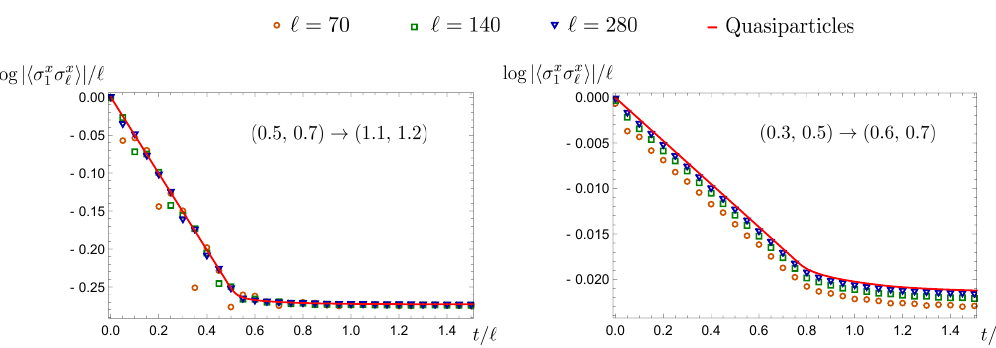
Figure 4: Evolution of the two-point correlator for various quenches { h t < 0 } n → { h } n in the inhomogeneous Ising model. We test the time evolution i i i = 1 i = 1 of the two-point correlator of the order parameter against the quasiparticle ansatz for increasing separation (cid:96) . It is evident that increasing (cid:96) the numerical data quickly ap- proach the quasiparticle ansatz. The initial exponential decay is due to the evolution of the one-point function of the order parameter since, on that time scale, we